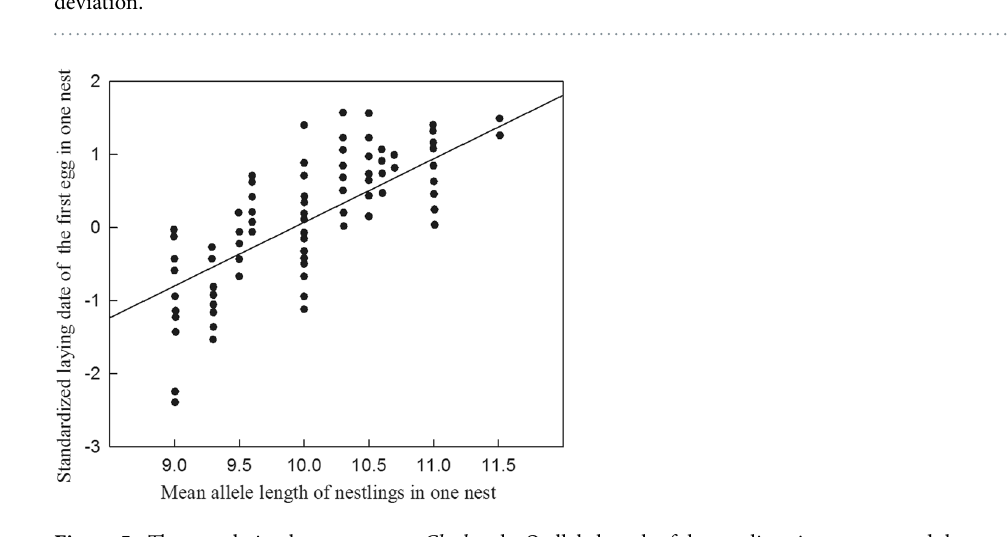
is the standard deviation of LD per year). Because a clutch can be laid within two days, we recorded the laying date of each clutch as the date on which the first egg was laid.